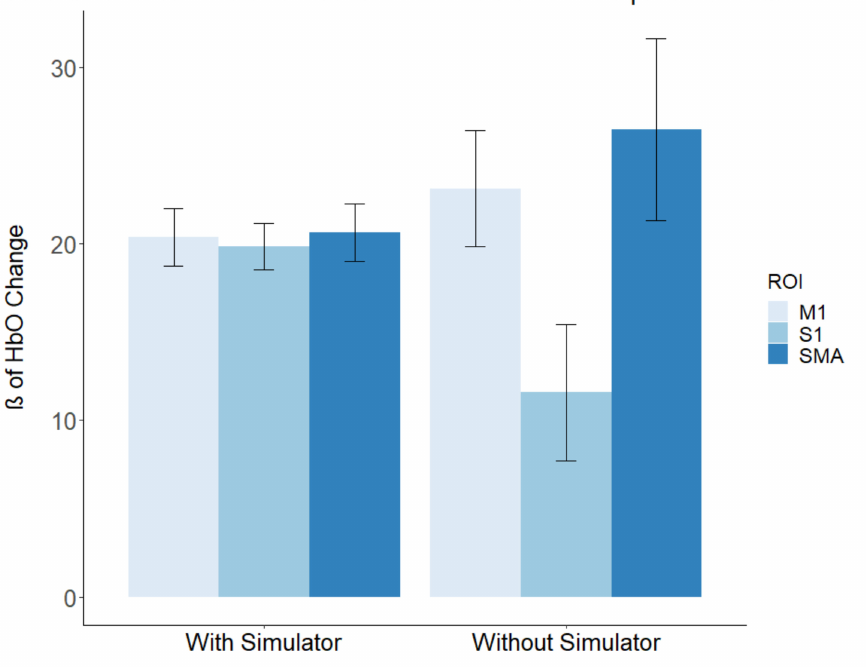
Figure 5. Activation in TD children with and without the prosthetic simulator. Beta (ß) values produced by the GLM are used as markers of activation with the brain, indicating that the activation matched the expected canonical hemodynamic response. The TD group displayed increased S1 activation during the simulator